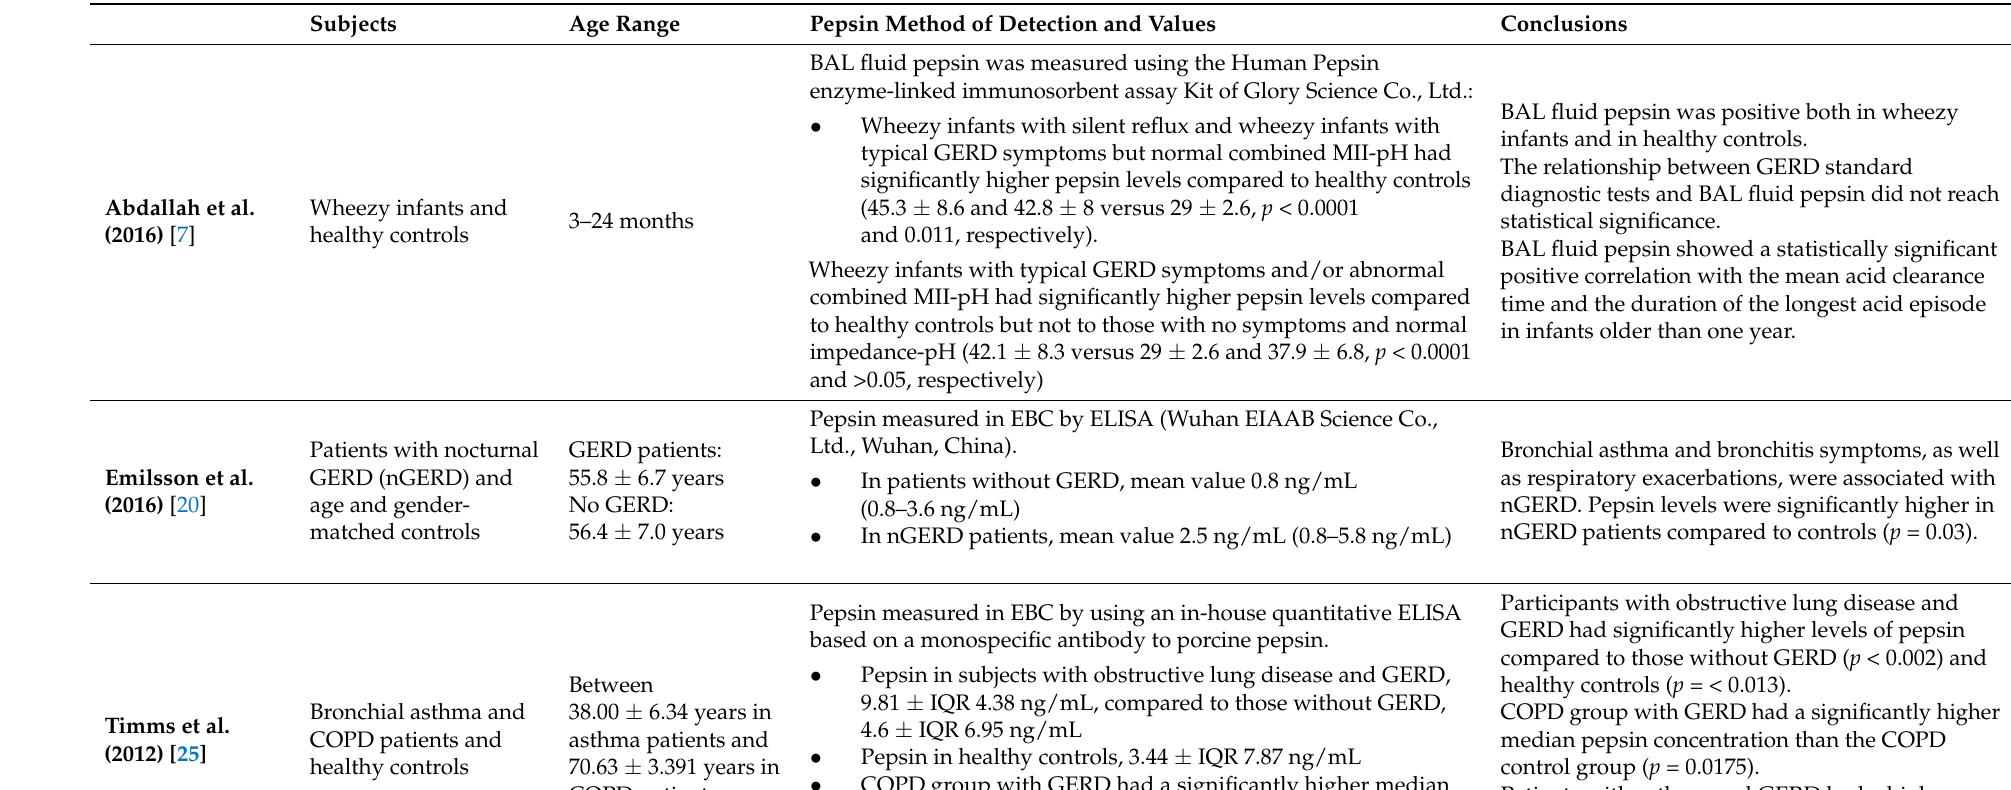
Table 1. Summary of the studies investigating pepsin levels in biological fluids retrieved from adult and paediatric subjects and the relationship between pepsin and obstructive lung disease (bronchial asthma,